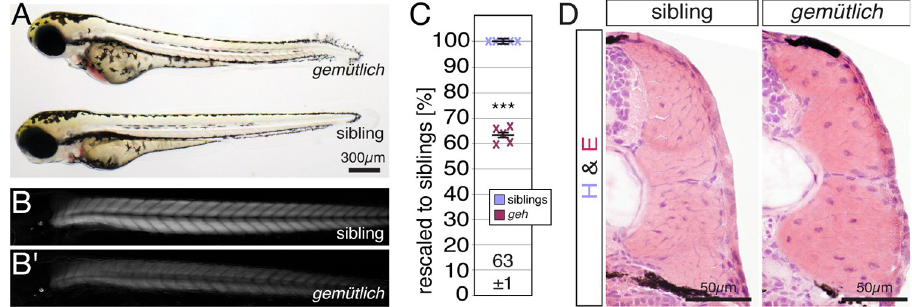
appeared darker in representative images taken under polarised light conditions. (C) After rescaling to siblings (100 ± 1%), the birefringence of 3-dpf-old geh homozygotes was significantly reduced to 61 ± 1%. Crosses represent averaged birefringence of clutches with a minimum of 6 larvae per genotype (n = 5 clutches). Data are presented as mean ± SEM; ��� P < 0.001 calculated by Student’s t-test. (D) Fibrotic signs were not detected on H&E-stained cross sections of 3-dpf-old geh homozygotes and siblings (n = 6 per genotype). Scale bar sizes are